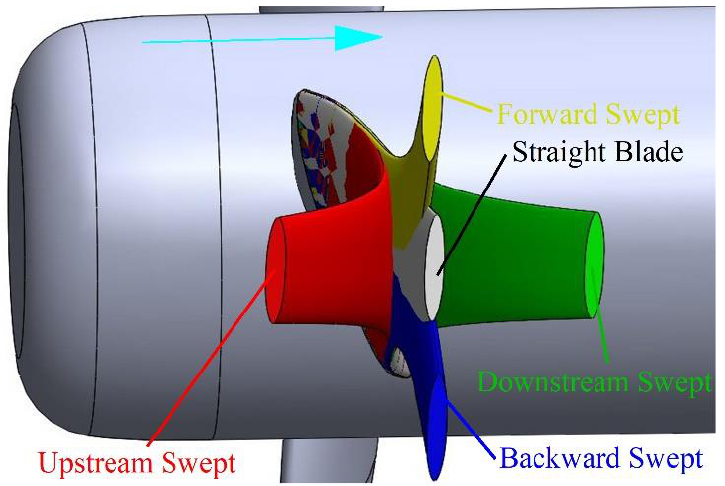
Figure 3. Sketch of four directions of the swept blade, with the cyan arrow being the direction of incoming flow.